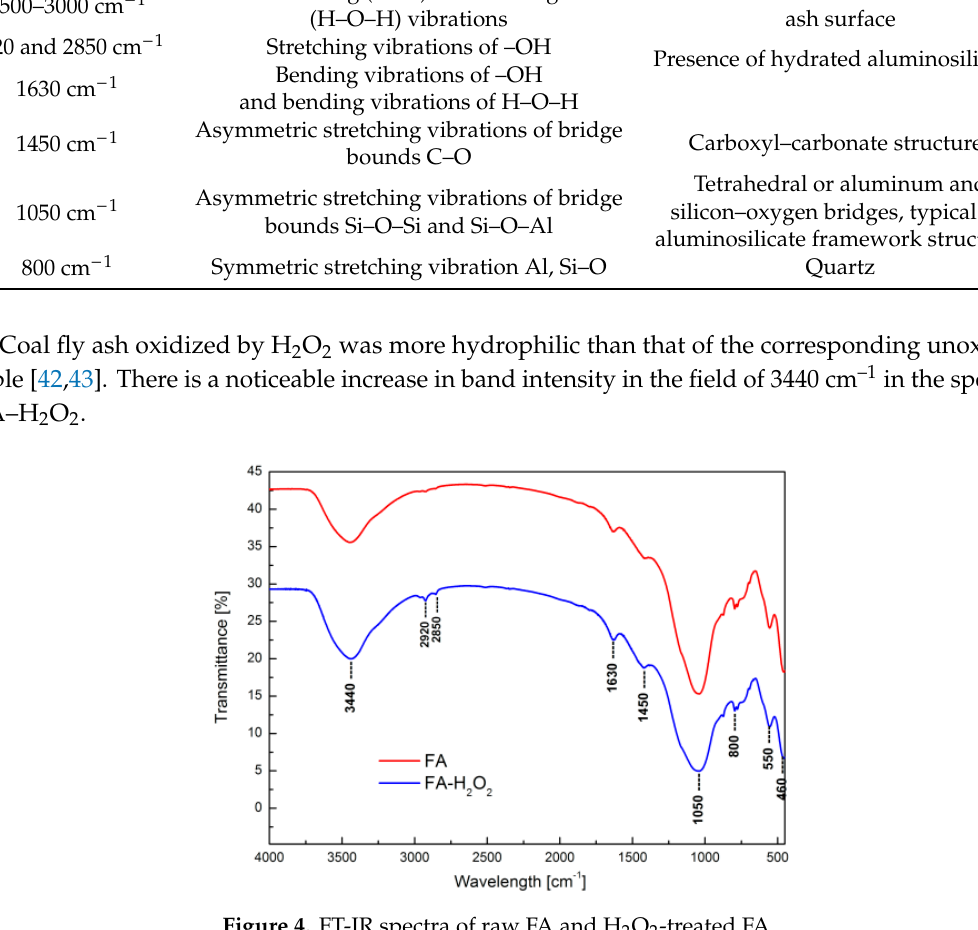
Figure 4. FT-IR spectra of raw FA and H 2 O 2 -treated FA.